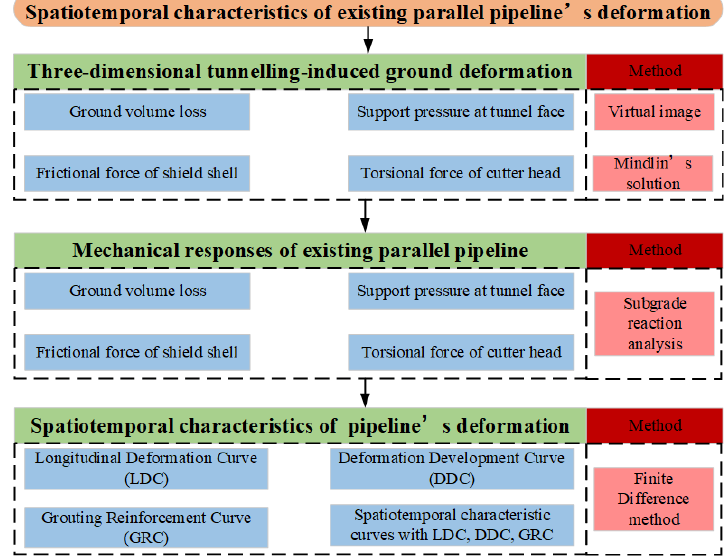
Figure 1. Flow chart of this